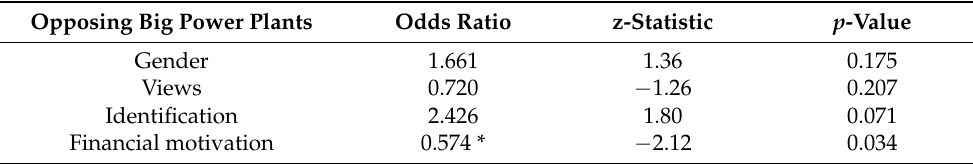
Table 5. Logistic regression: opposing big power plants.